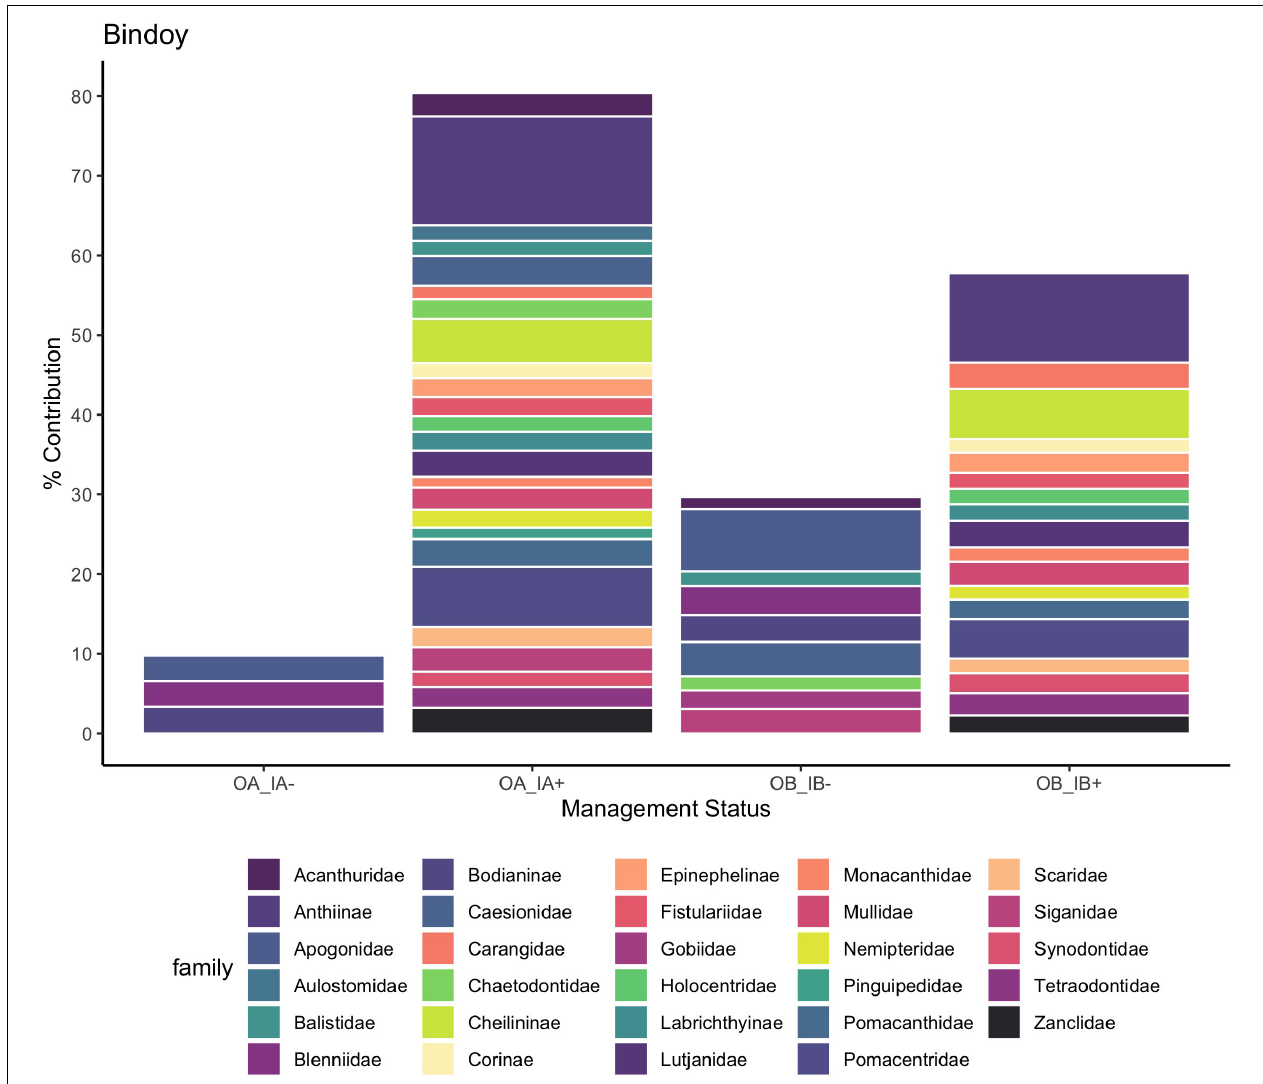
FIGURE 4 | Percent contribution to the dissimilarity between inside and outside before (average dissimilarity 30.36) and after (average dissimilarity 34.82) CBM implementation in Bindoy, aggregated by family. OA, outside marine reserve; after CBM implementation; OB, outside marine reserve; before CBM implementation; IA, inside marine reserve; after CBM implementation; IB, inside marine reserve; before CBM implementation. + means that there was higher abundance after CBM, – means there was lower abundance after